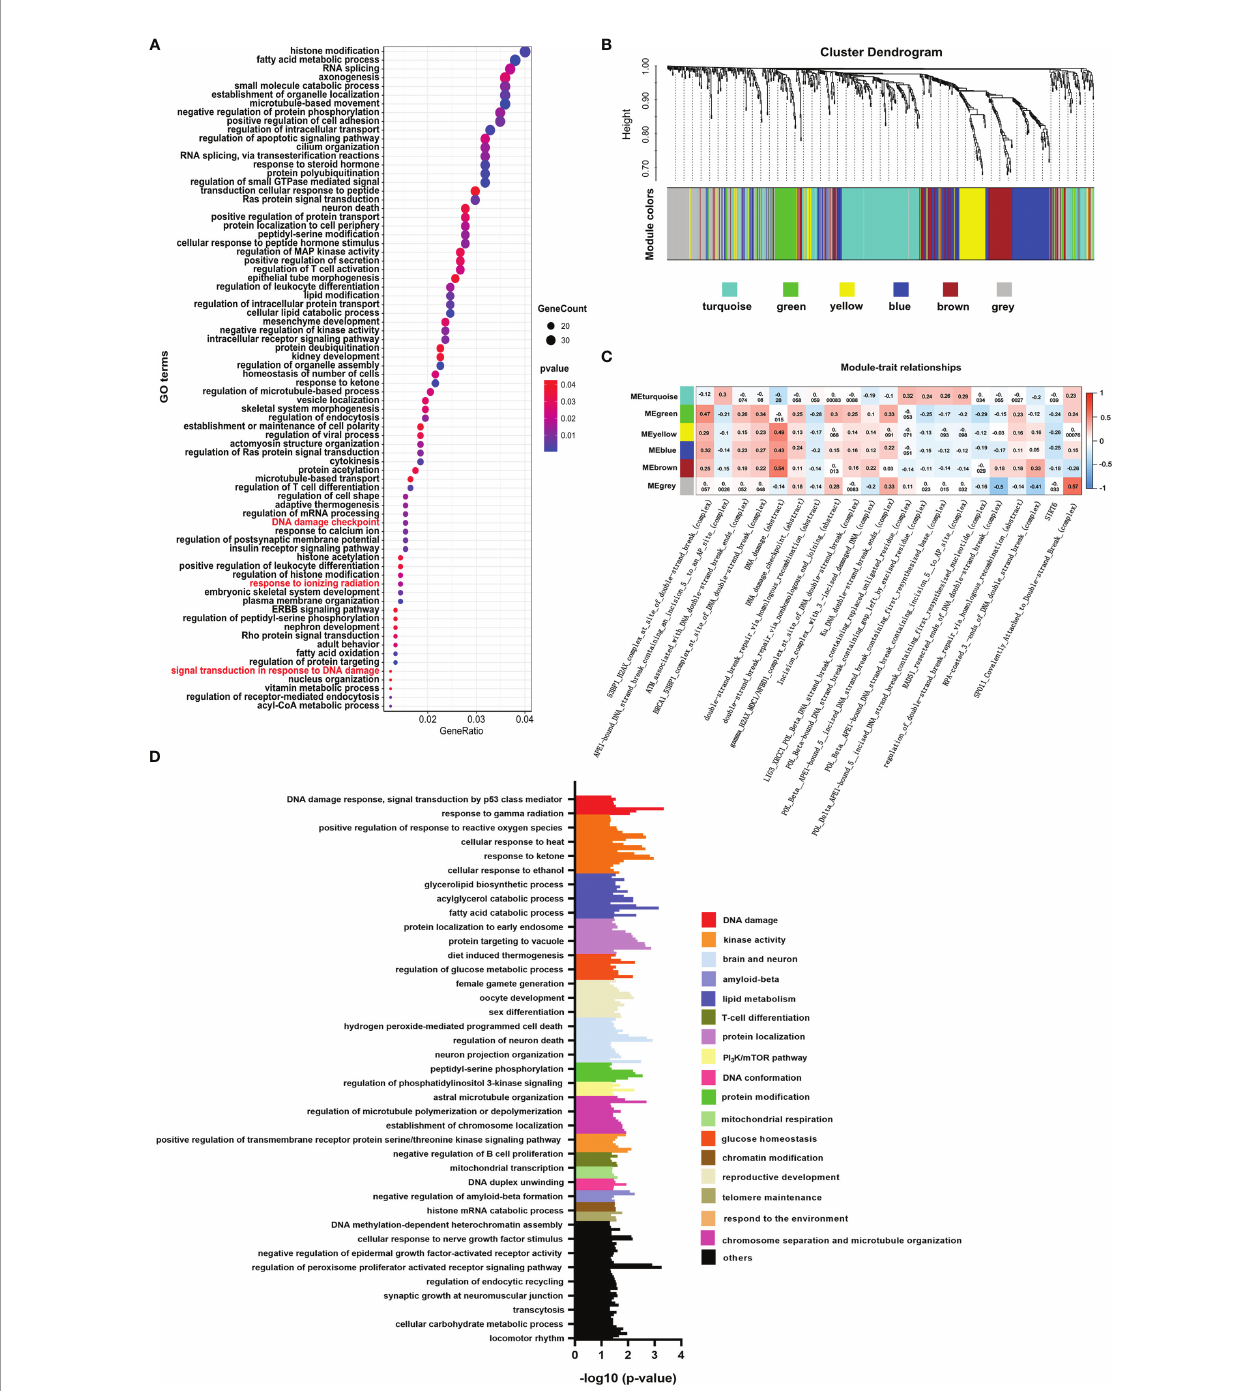
FIGURE 1 | Histone crotonylation is related to DNA damage in colon cancer. (A) Gene ontology (GO) analyzing the enrichment items of genes with promoter occupied by histone crotonylation in sub-ontologies of biological processes (GSE124540). The circle size indicates the number of genes in each item. The color intensity indicates the negative base 10 logarithm of the p -value. The items with red color mean that the pathways were involved in DNA damage. (B) Weighted gene co-expression network analysis (WGCNA) of the gene co-expression module of the same gene set mentioned above in The Cancer Genome Atlas colon adenocarcinoma samples. (C) WGCNA of the relationship between each module and DNA-damage-related complexes or abstract processes in paradigm IPLs. The color intensity indicates the correlation coef fi cient. Red indicates a positive correlation, and blue indicates the opposite. (D) Gene Ontology analysis of the functional enrichment of genes enriched in the green